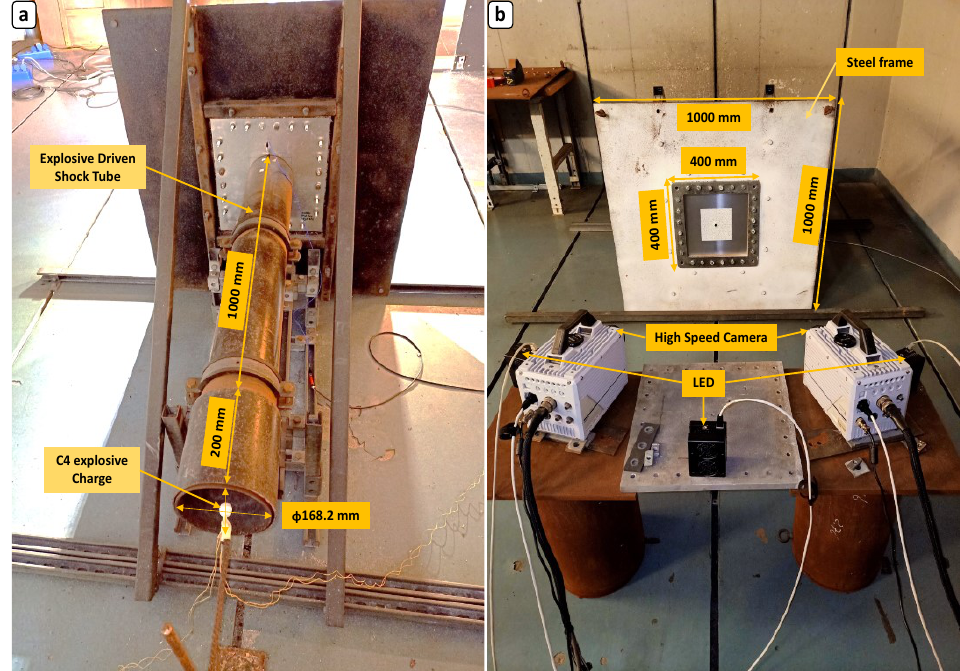
Figure 14. Experimental setup for testing the aluminum plates perforated using fragment-simulating projectiles under blast loading: ( a ) explosive-driven shock tube dimensions; ( b ) instrumentation used for the application of the digital image correlation